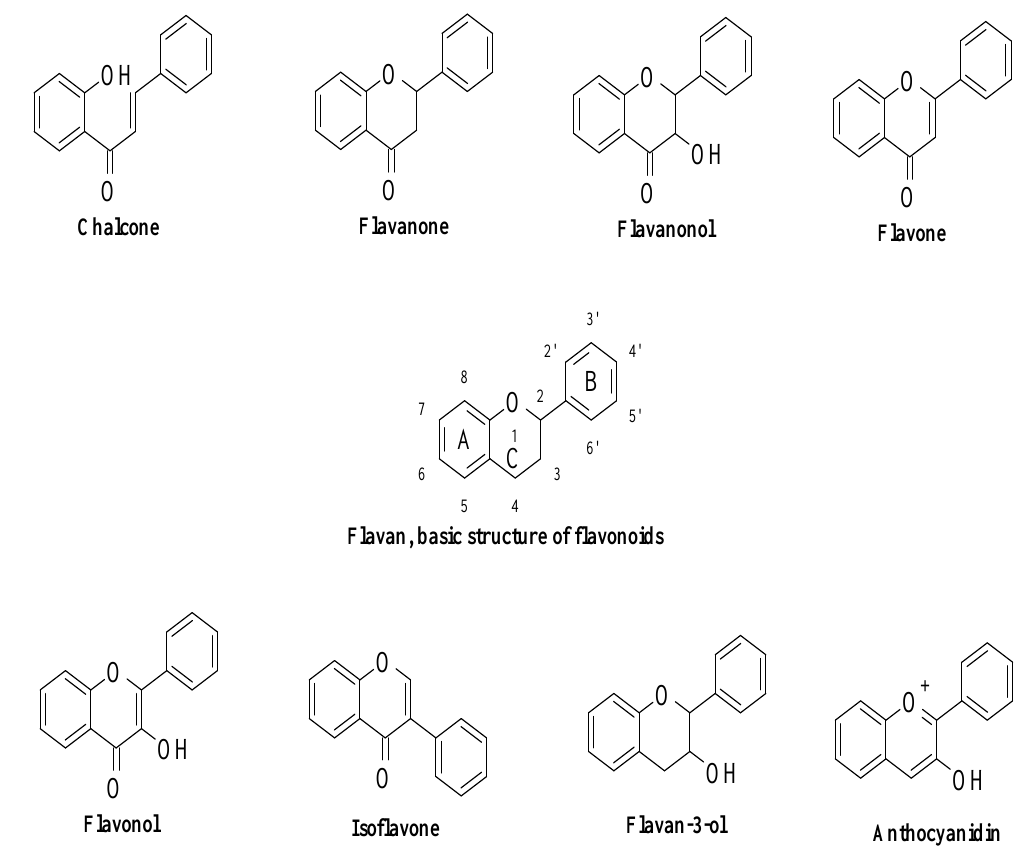
Figure 1. Flavonoids’ main classes.